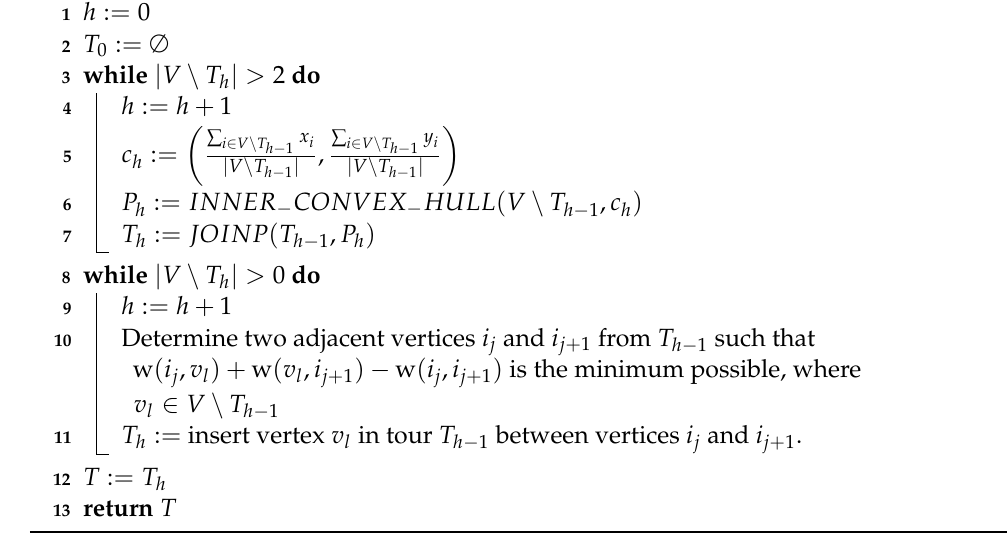
Algorithm 4: JOINP ( T h − 1 , P h ).